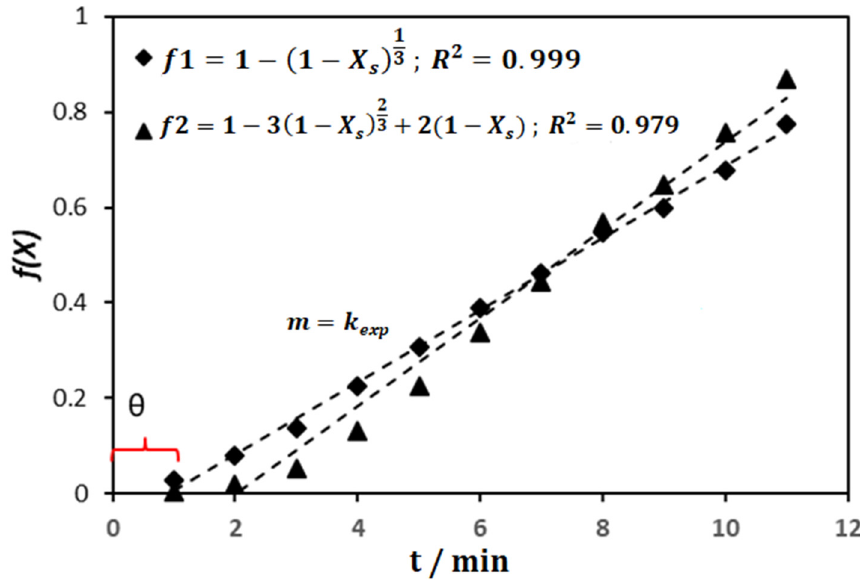
Figure 8. Assessment of the equations corresponding to chemical control and control by mass transport; X S is the sulfur fraction in the NaOH solution; pH = 12.85, 303 K (30 °C), d 0 = 38 µm, RPM = 500 min − 1 ).